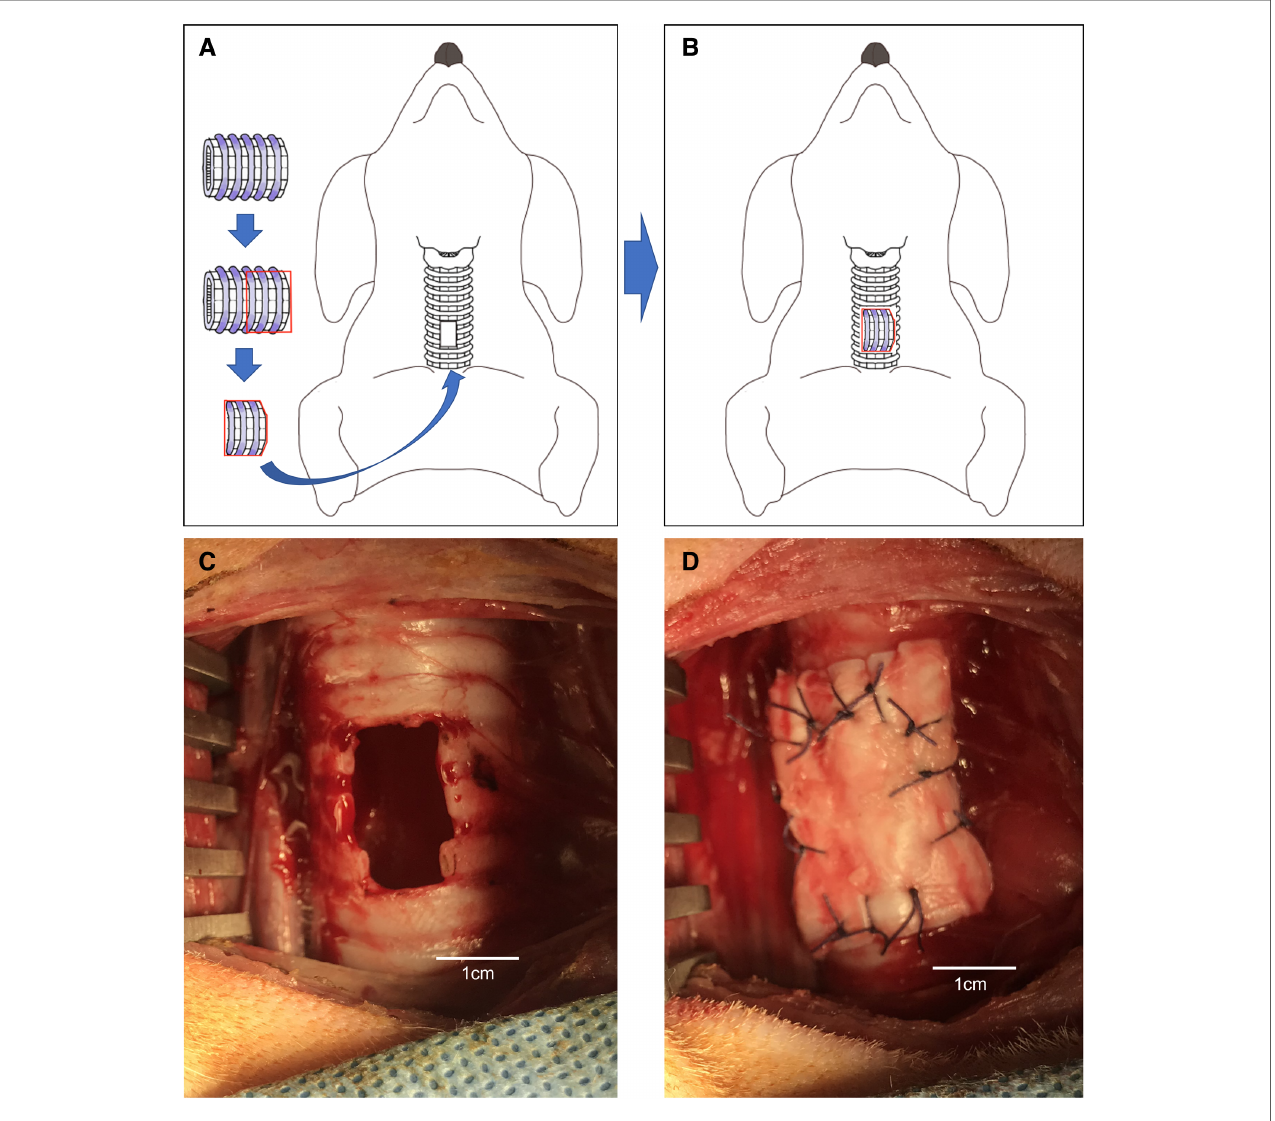
FIGURE 3 ( A,B ) Schematic of the porcine extracellular matrix transplanted perpendicular to a tracheal defect (hole) in a dog. ( C ) Tracheal defect (hole) in a dog. ( D ) P- ECM transplanted perpendicular to a tracheal defect (hole) in a dog.